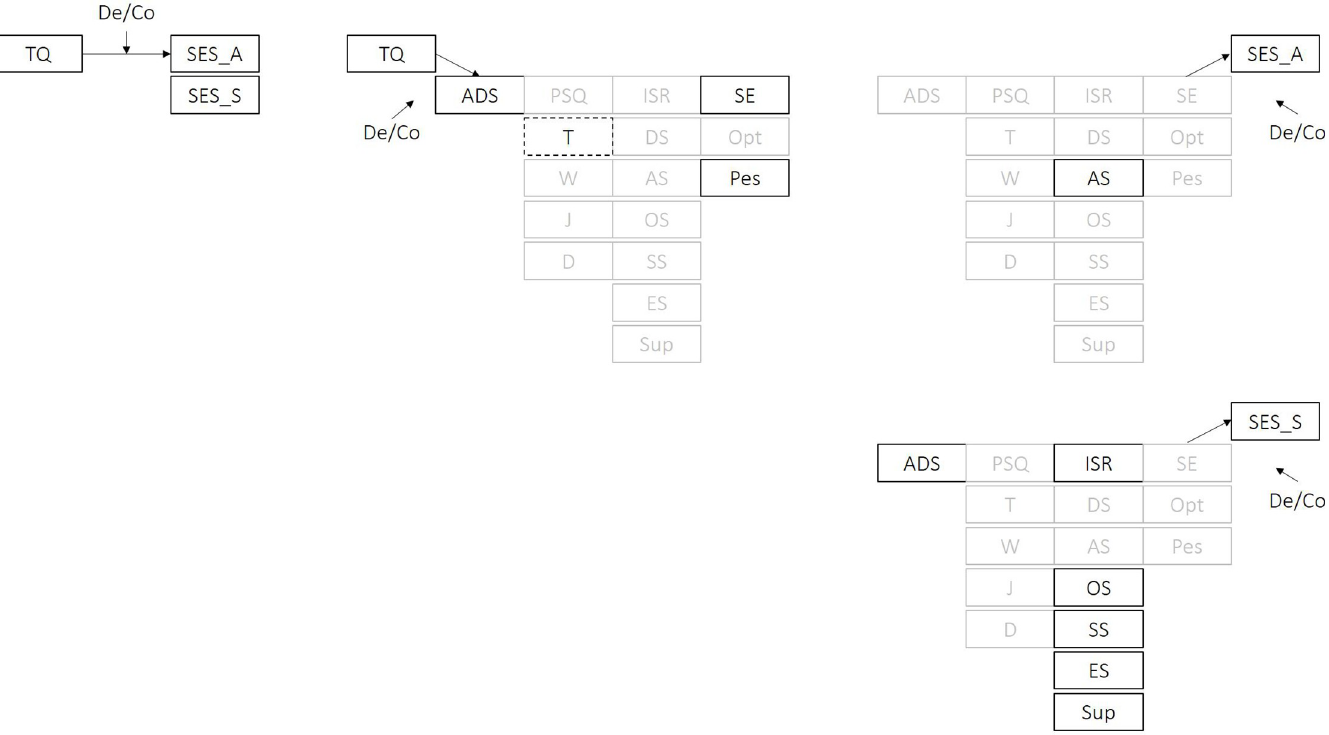
Fig 3. Graphical illustration of simple moderation effects. De/Co indicates the specification of tinnitus decompensation vs. compensation as a putative moderator of paths c (left), a (middle) and b (right upper row: affective pain perception; lower row: sensory pain perception). Continuous black box frames indicate that respective effects are stronger in patients with decompensated vs. compensated tinnitus, dotted box frames the opposite. Greyed out boxes indicate non-moderated effects. TQ = Tinnitus Questionnaire–German version total score, SES_A = Affective Pain Perception Scale: SES_S = Sensory Pain Perception Scale, ADS = Center for Epidemiological Studies Depression Scale total score, PSQ = Perceived Stress Questionnaire total score, T = tension, W = worries, J = joy, D = demands, ISR = ICD-10 Symptom Rating total score, DS = depressive syndrome, AS = anxiety-related syndrome, OS = obsessive-compulsive syndrome, SS = somatoform syndrome, ES = eating-related syndrome, Sup = supplementary scale, SE = Self-efficacy scale, Opt = Optimism scale; Pes = Pessimism scale. Significance levels were set at p < .05.